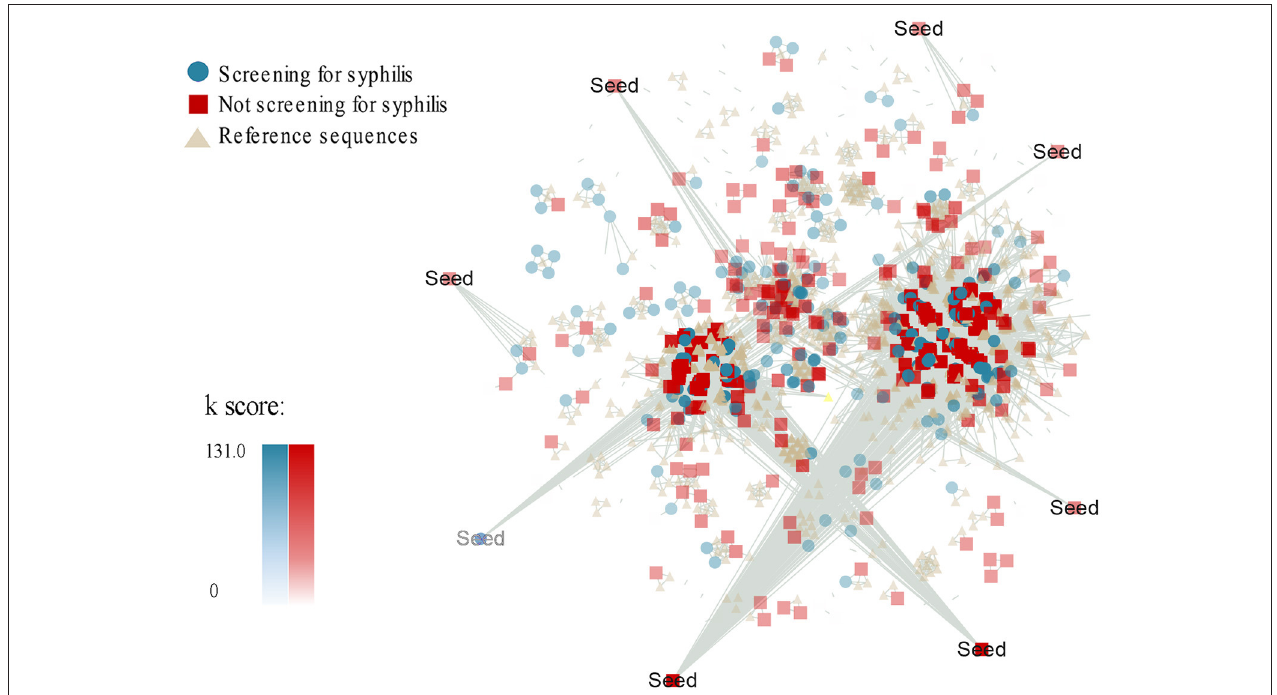
FIGURE 1 | Ks score-associated and group-associated genetic transmission networks for MSM with or without syphilis testing during 2008-2012 in Guangzhou, China. Ks score was measured by a K-shell decomposition algorithm. The colors and shapes represent different groups of the HIV-1 sequences from the MSM with syphilis screening (green circle) or without syphilis screening (red square) and the HIV-1 reference sequences (light yellow triangle). The density of the colors indicates the Ks score values. Seed is the highest scoring node in the densely connected sub-networks. their occupations were most unlikely to receive syphilis